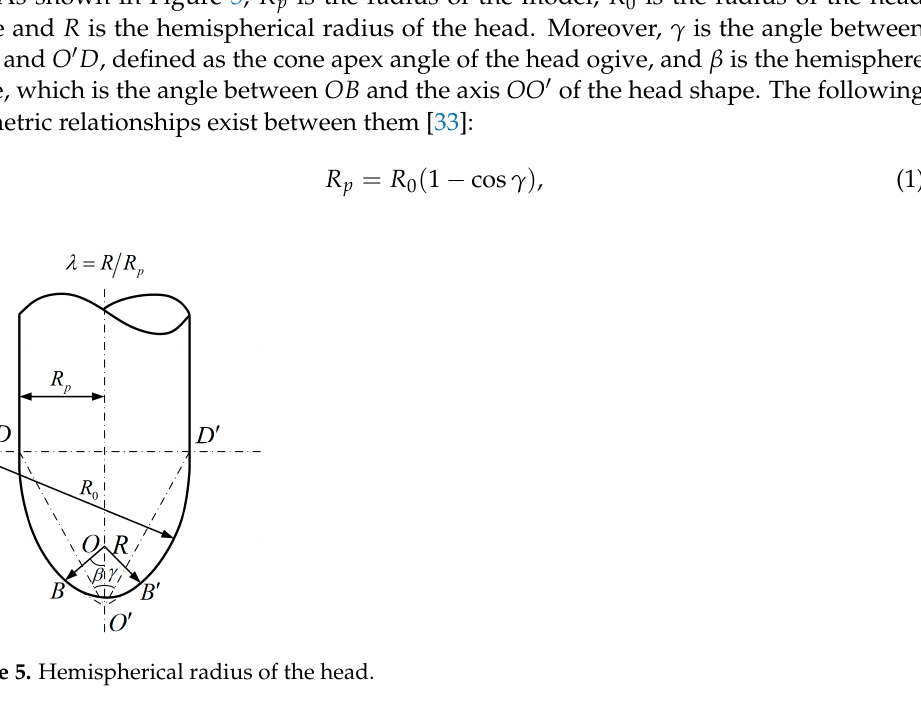
Figure 4. Model physical map.